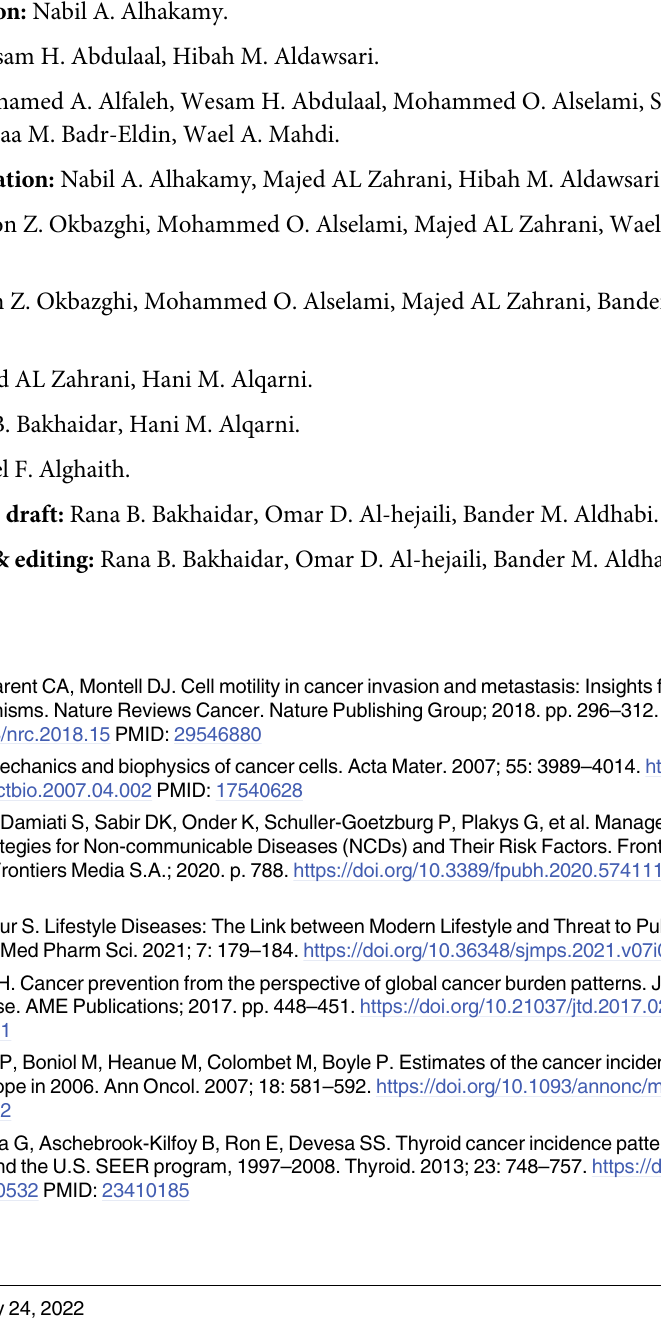
S1 Fig. The figure showing the individual effect of